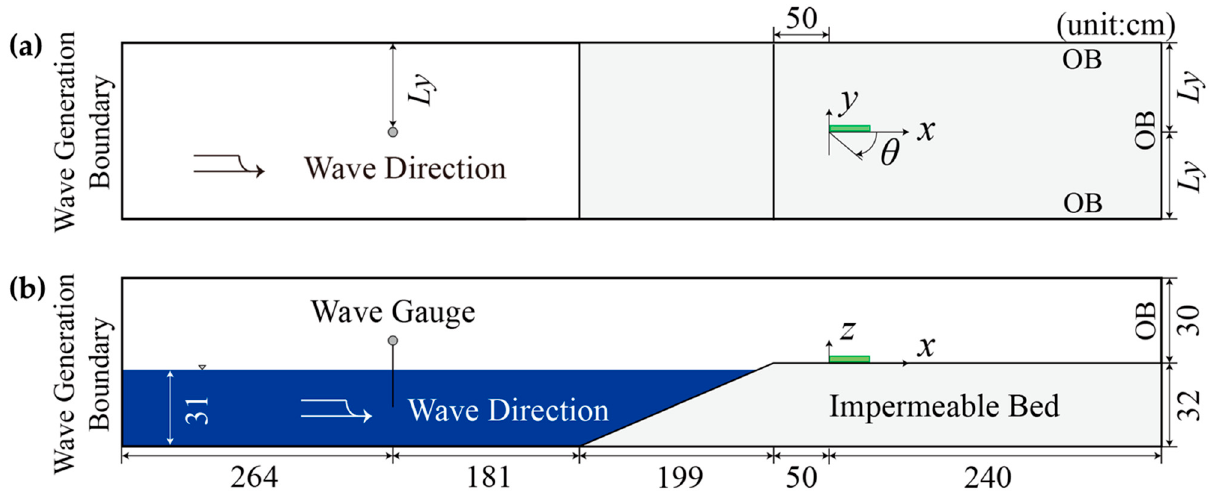
Figure 5. Numerical computational domain, showing the impermeable bed and wave gauge used as well as the numerical simulation domain location: ( a ) plan view; ( b ) elevation view. The computational domain edges show wave generation boundary and open boundary (OB).